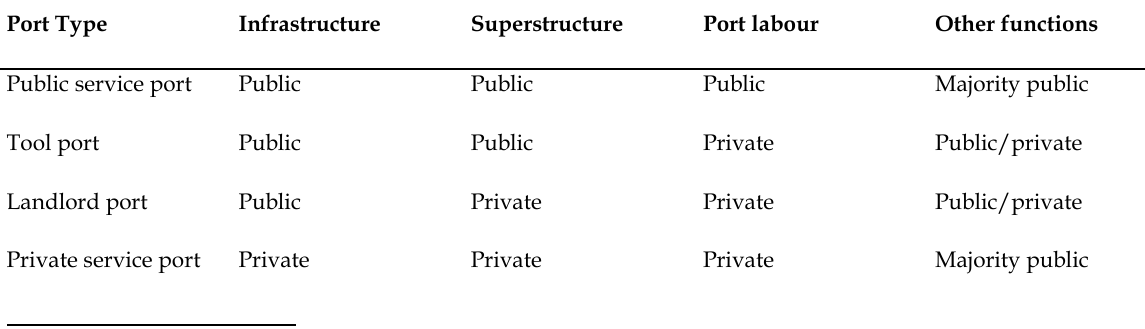
Table 1. Typology of Port Ownership WBPRTK